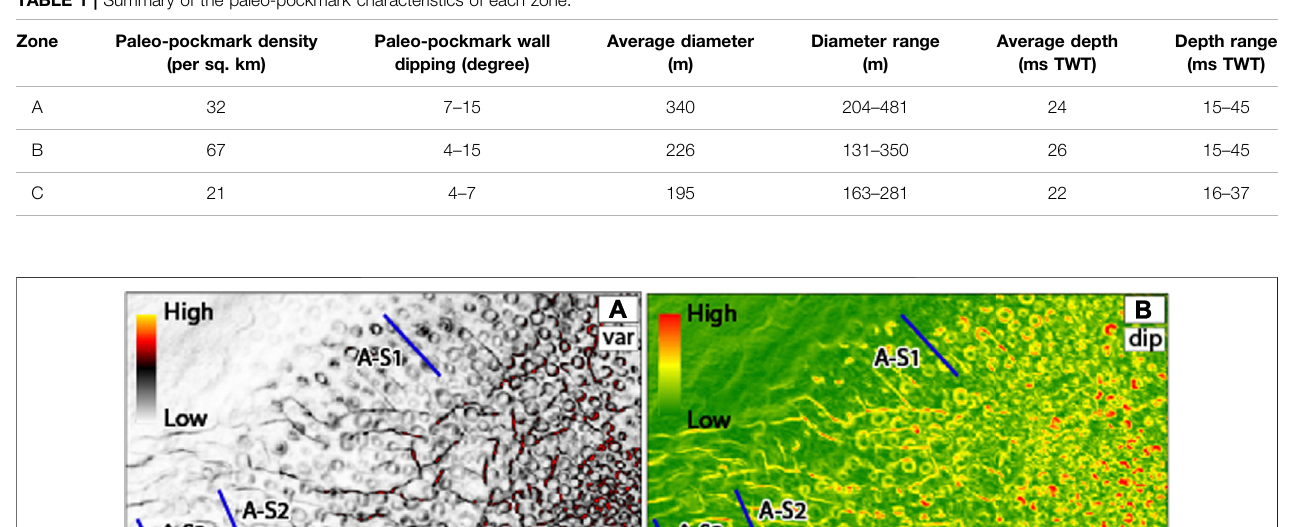
Frontiers in Earth Science |